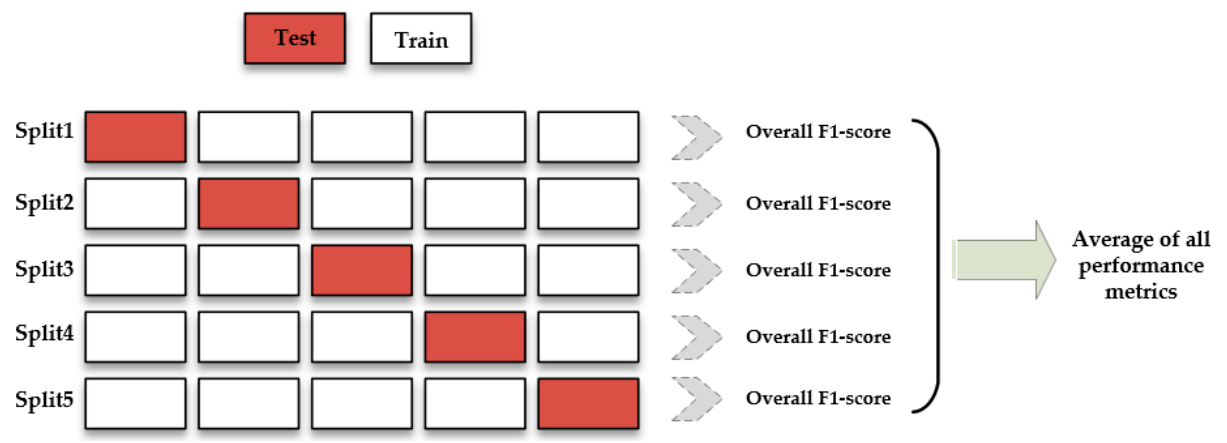
Figure 9. K-fold cross validation procedure.